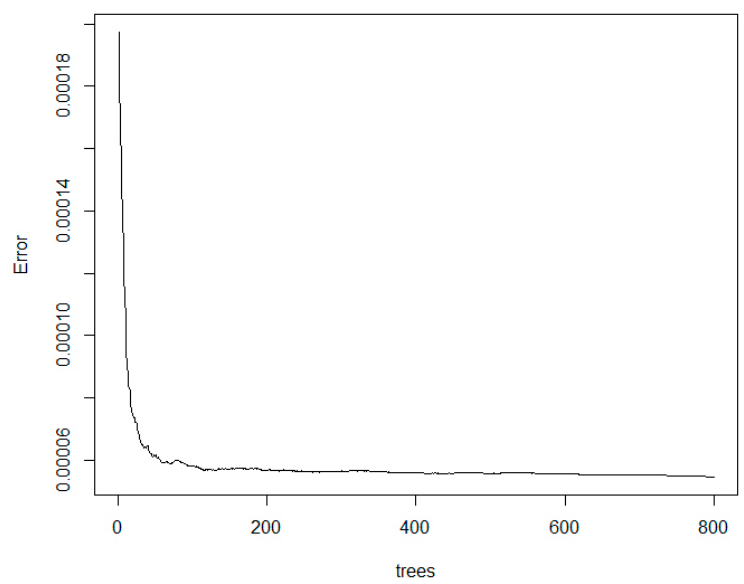
Figure 6. RF decision tree for the out-of-bag (OOB) error.